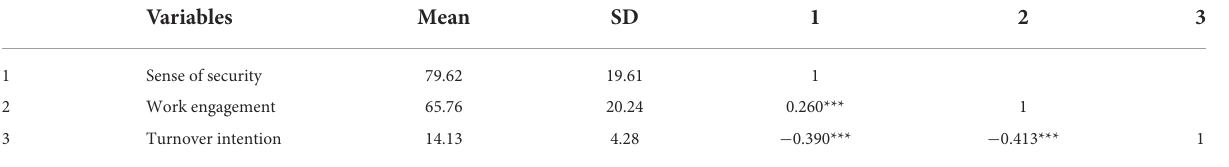
TABLE 2 Means, standard deviations (SD) and correlations among study variables ( N = 2480).